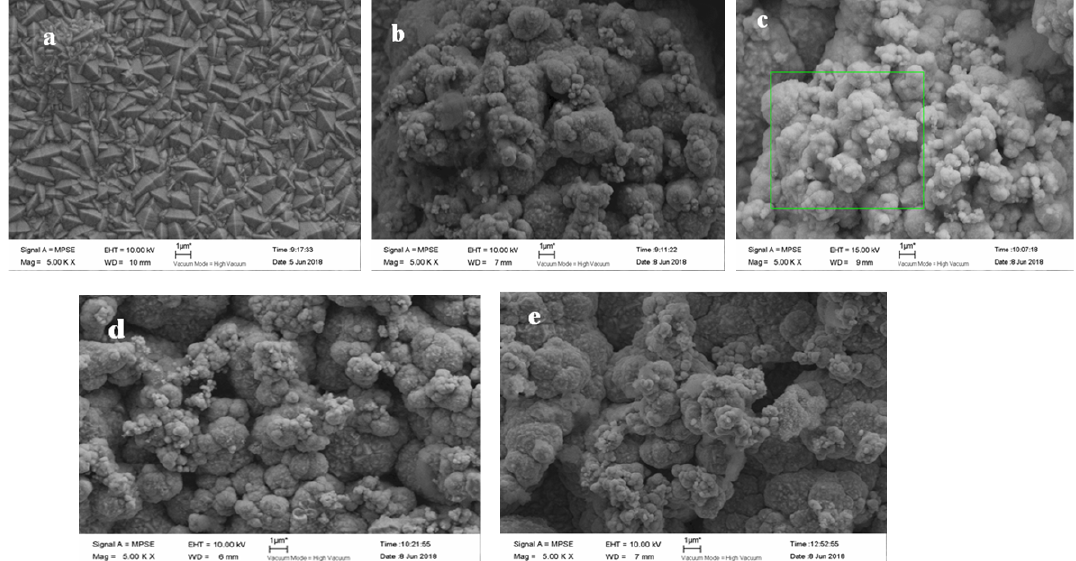
Figure 12. SEM images of composite coating plated at nanodiamond concentrations from 0 g / L to 16.0 g / L in plating solution: ( a ) 0 g / L, ( b ) 4.0 g / L, ( c ) 8.0 g / L, ( d ) 12.0 g / L, and ( e ) 16.0 g / L.